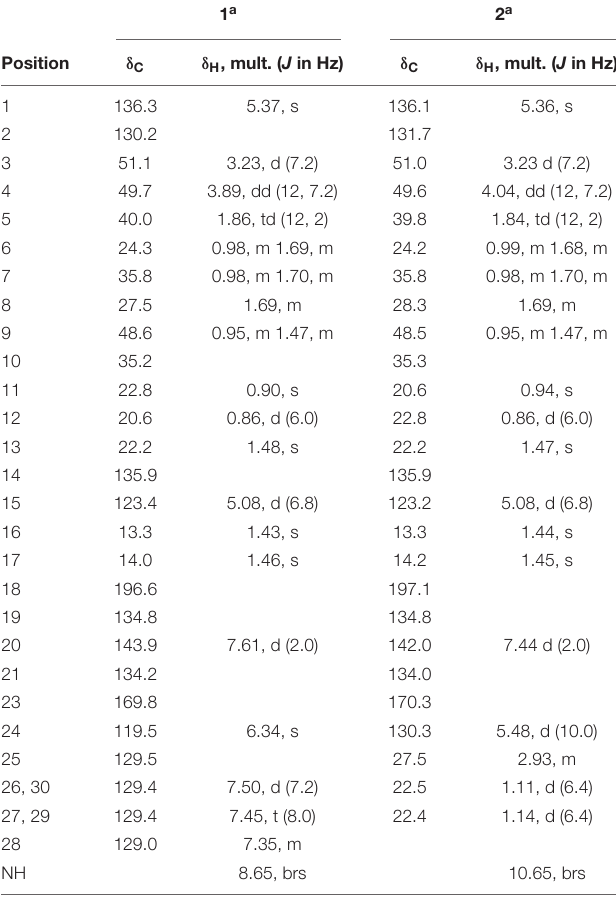
TABLE 2 | 1 H and 13 C NMR data of 1 and 2 ( δ H in ppm, J in